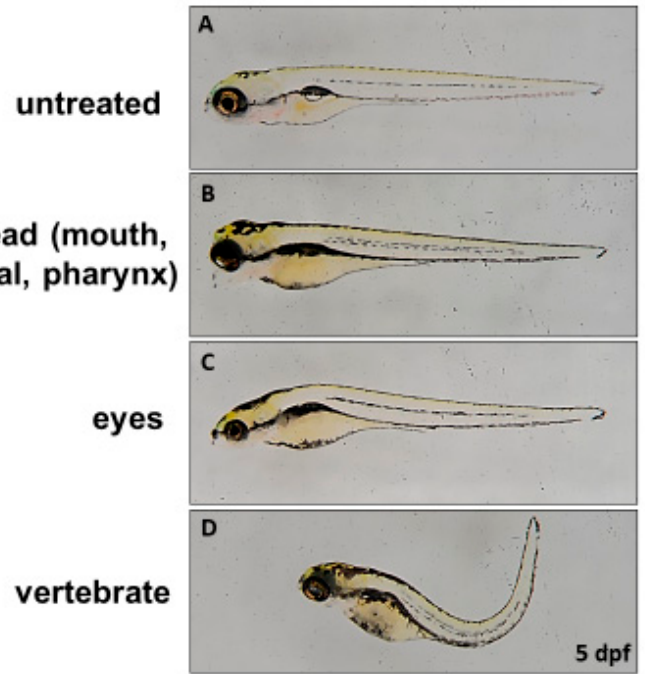
Figure 3. Overexpression of a homologous mutated ids found in MPS II interferes with the embryonic development of zebrafish. Embryonic phenotypes at one-cell stage were examined at 5 dpf in zebrafish embryos injected with 300-pg z- ids -S327L mRNA, which corresponds to h - IDS - S333L. ( A ) Untreated embryos; ( B – D ); embryos injected with mutant z- ids -S327L: ( B ) head defect, including smaller size and malformation of the craniofacial and pharyngeal arch; ( C ) eye defect, including smaller eyes; and ( D ) body axis defect, including shortened somites and curved body axis.